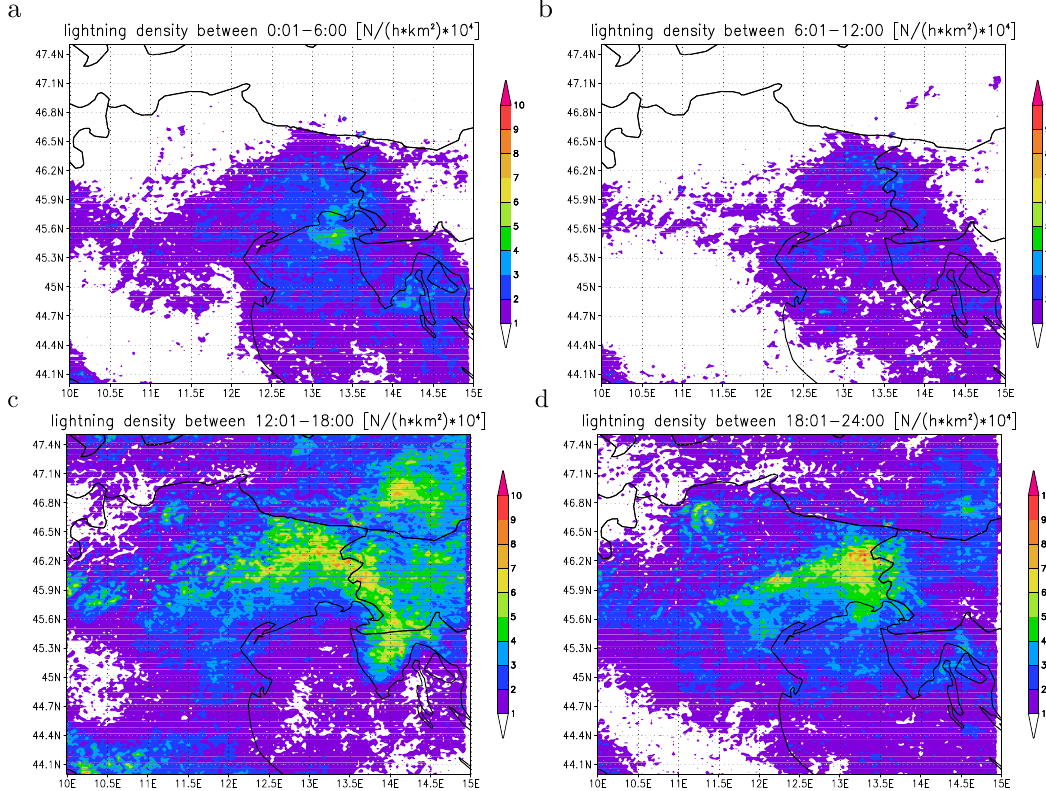
Figure 7. Daily cycle spatial distribution of C2G lightning: (a) 00:00–06:00UTC, (b) 06:00–12:00UTC, (c) 12:00–18:00UTC and (d) 18:00–24:00UTC. The peak is in the afternoon over land moving than to the coastal area and the sea during the night. Units are number of flashes per hour per km 2 times a factor of 10 4 .